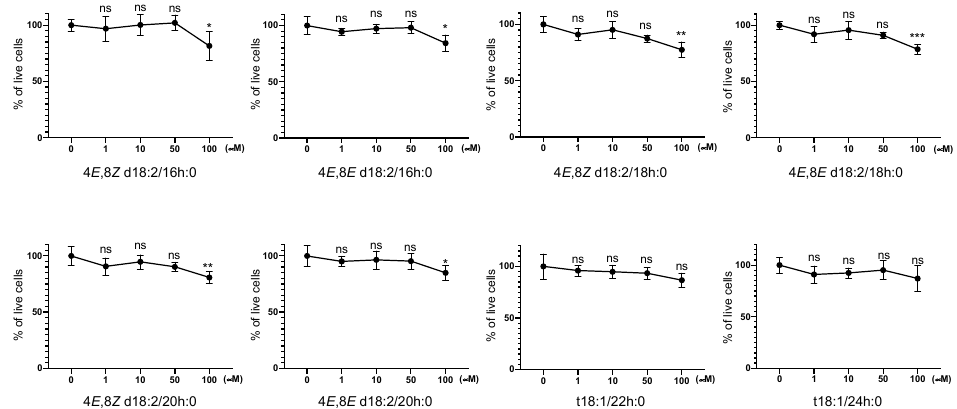
Figure 2. Cell Counting Kit-8 (CCK-8) cell viability assays of SH-SY5Y cells exposed to typical plant Cers. Results were normalized against controls and were represented as the mean ± standard deviation (SD; n = 4; * p < 0.05, ** p < 0.01, *** p < 0.001 vs. controls by t -test).